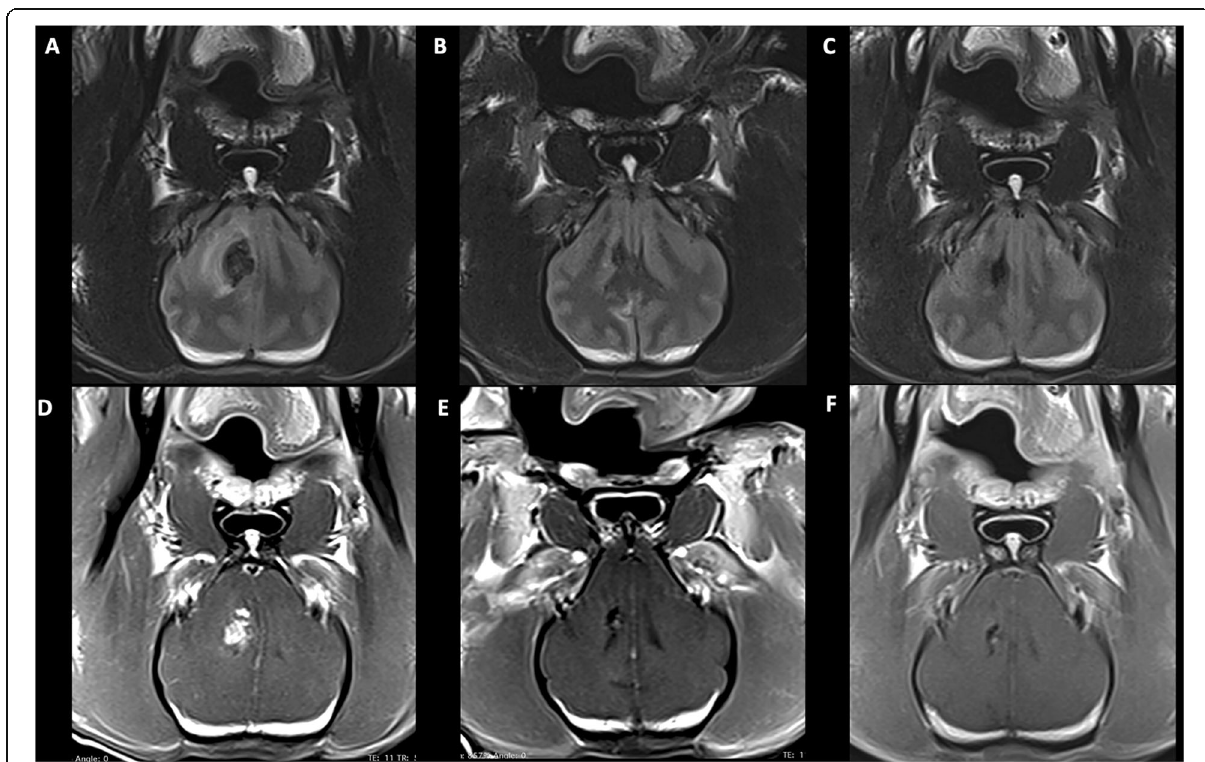
Fig. 6 a – c P1 T2-FLAIR imaging at 2 weeks prior to treatment ( a ), 1 month ( b ), and 6 months ( c ) following 90 Y-RE. d – f T1 post-contrast imaging at 2 weeks prior to treatment ( d ), 1 month ( e ), and 6 months ( f ) following 90 Y-RE. At 1 month post-therapy, there is a decrease in lesion size with a resolution of perilesional edema and absence of contrast enhancement. The resolution of midline shift without evidence of cortical atrophy was also noted. Treatment effect is maintained at 6 months with a continued decrease in lesion size. Additional images showing the progression of P4 which had a less impressive response are shown in the